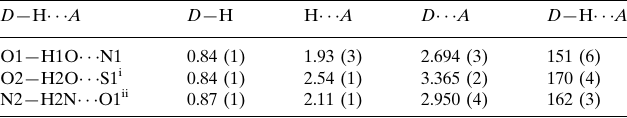
Hydrogen-bond geometry (A˚ , (cid:2)